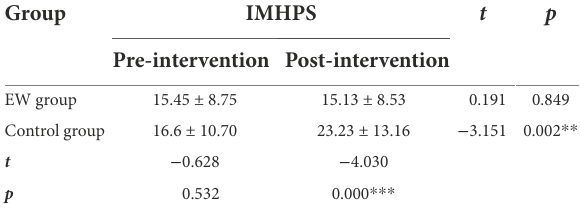
TABLE 4 Comparison of IMHPS before and after intervention between two groups (score).